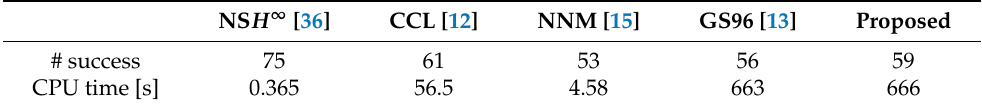
Table 1. Stabilizing static controller design results.